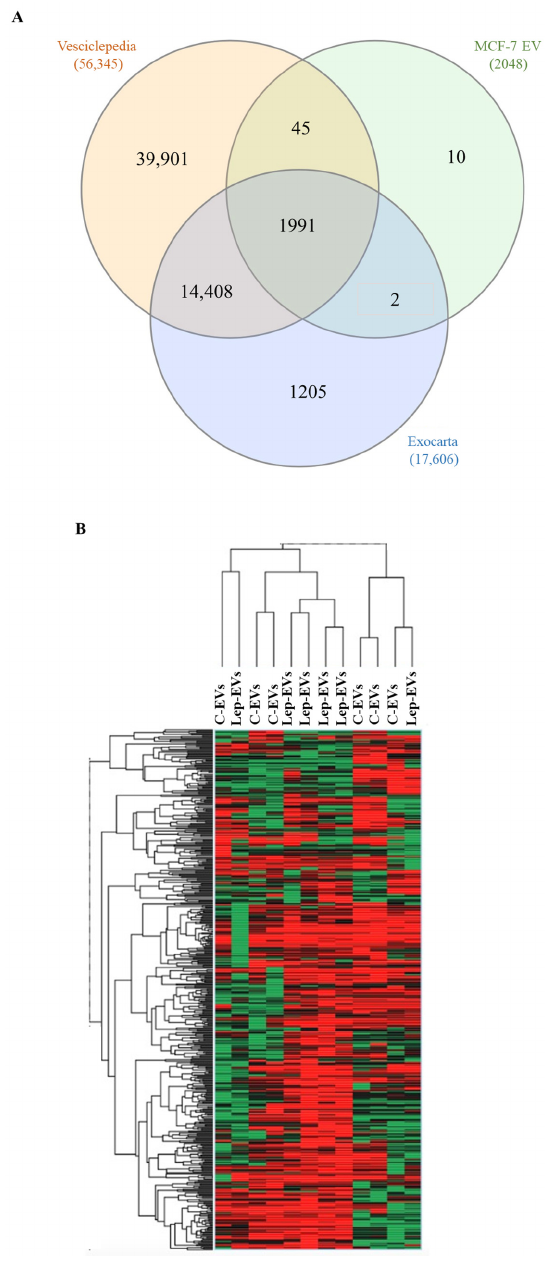
Figure 2. Proteomic profiling of EV lysates from breast cancer cells. ( A ) Venn diagram of proteins identified in the EVs from MCF-7 breast cancer cells compared with proteins annotated in the Vesiclepedia and Exocarta databases using Bioinformatics & Evolutionary Genomics (https://bioinformatics.psb.ugent.be/webtools/Venn/, accessed on 1 November 2021) tool. ( B ) Heatmap of the differentially expressed proteins in C-EVs and Lep-EVs identified by LC-MS/MS analysis. The color scale illustrates the relative expression of each protein across the 12 samples. Heatmap coding uses increasing brightness of red for degree of up-regulation and green for down-regulation. Black color stands for a median expression